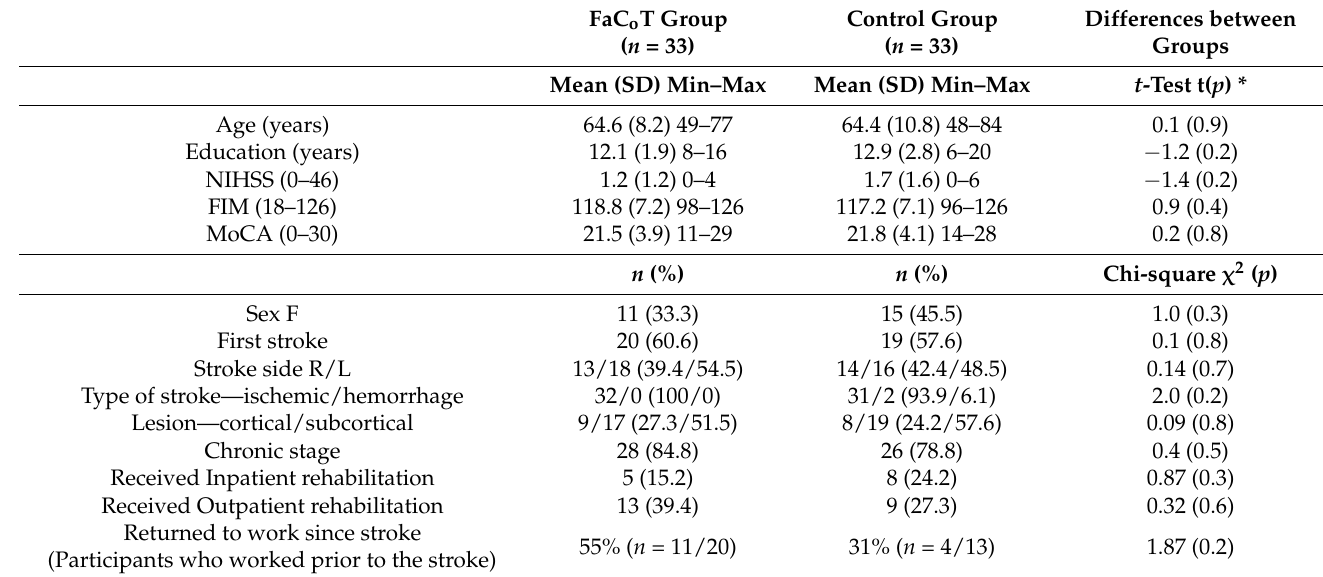
Table 1. Demographic, functional and stroke-related characteristics of participants in both groups at